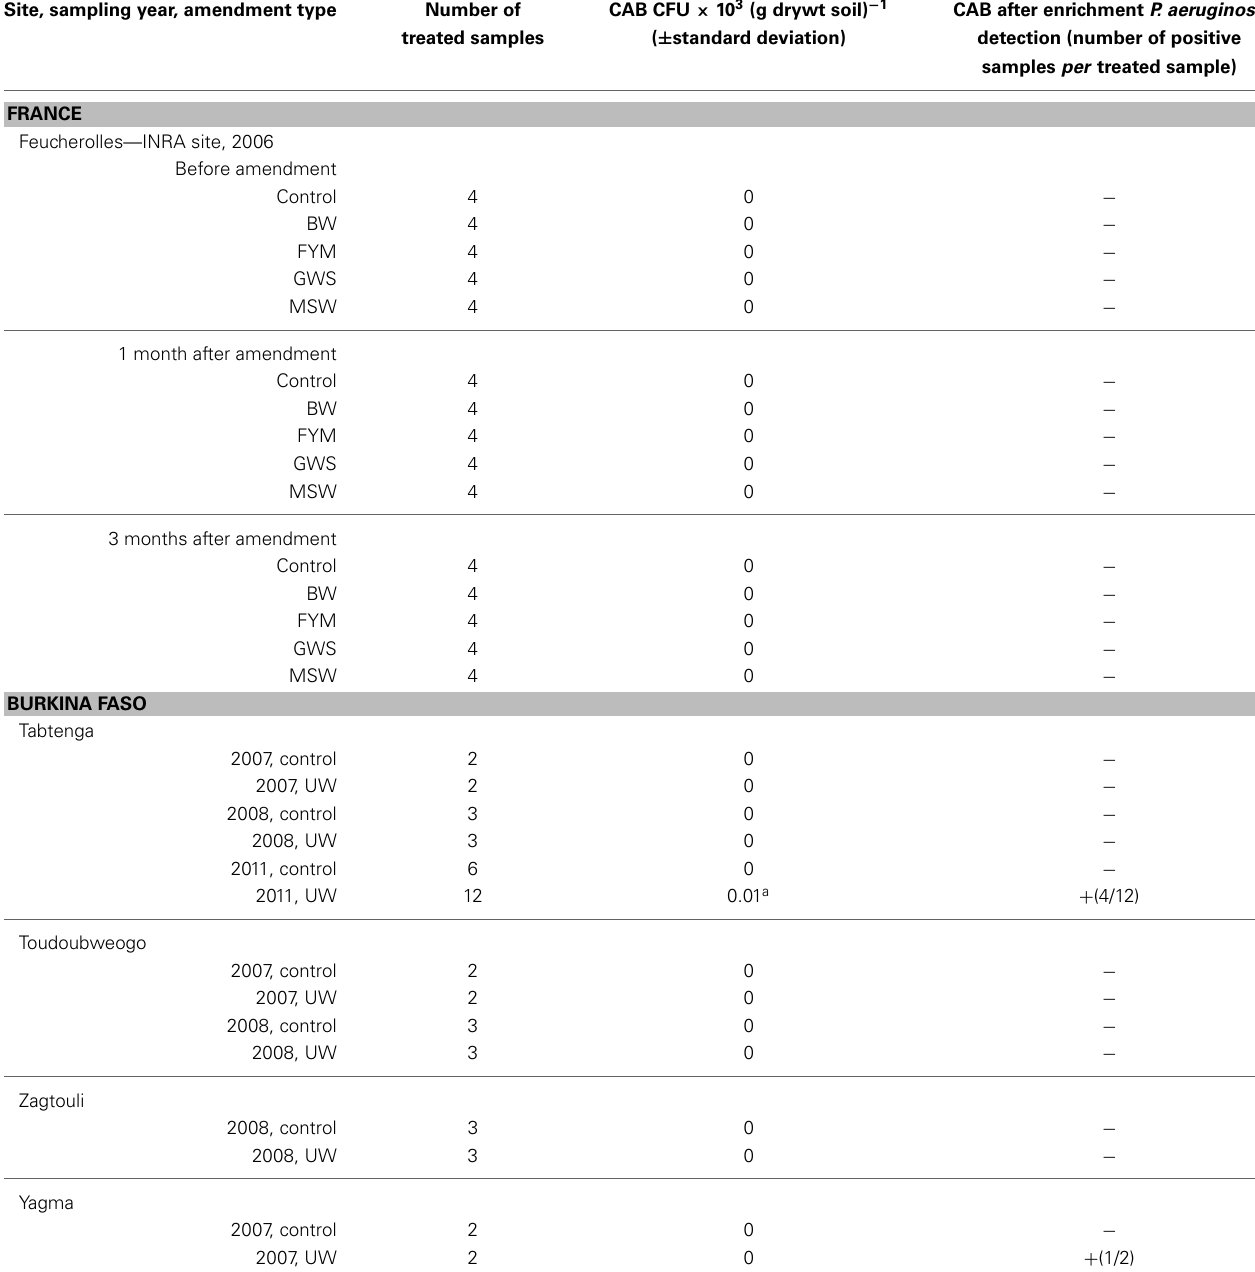
Table 2 | Culture-based detection of P. aeruginosa in soils exposed to various organic